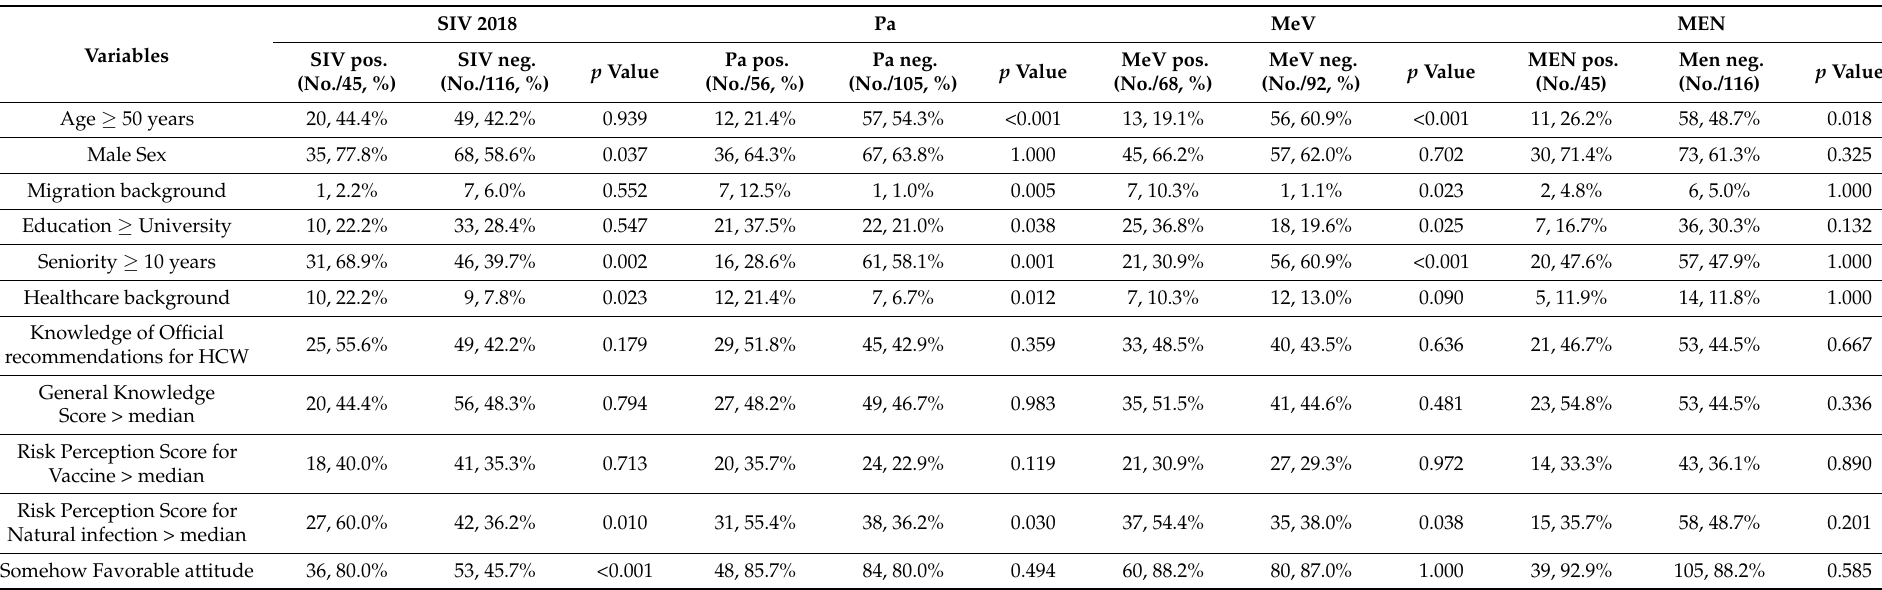
Table 4. Univariate analysis of the association between individual factors and having been vaccinated against seasonal influenza (SIV) 2018, pertussis (Pa), measles (MeV), meningitis (any vaccine, MEN). Note: HCW = healthcare